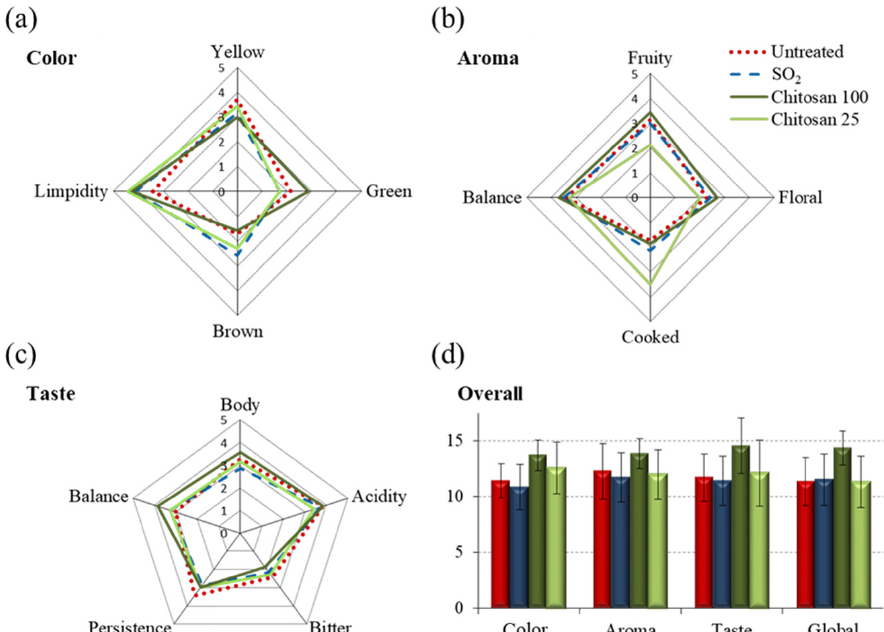
Figure 1. Descriptive sensory analysis of ( a ) color, ( b ) aroma, ( c ) taste and ( d ) overall global attributes evaluation of white wines. The wines were analyzed after 12 months of storage under the following conditions: without preservative treatment (red lines/bars), treated with SO 2 (blue lines/bars), treated with 100 cm 2 Ch-Ge films (Chitosan 100, dark green lines/bars) and with 25 cm 2 Ch-Ge films (Chitosan 25, light green lines/bars).